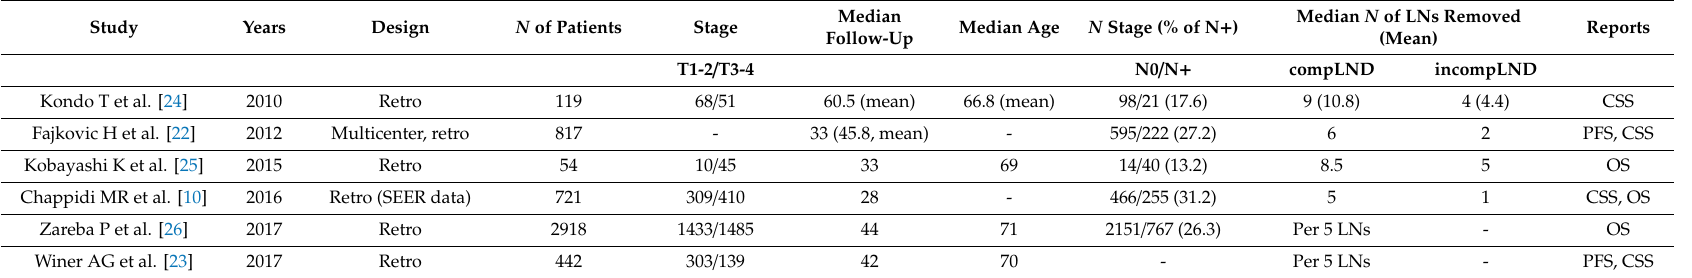
Table 1. Characteristics of the eligible